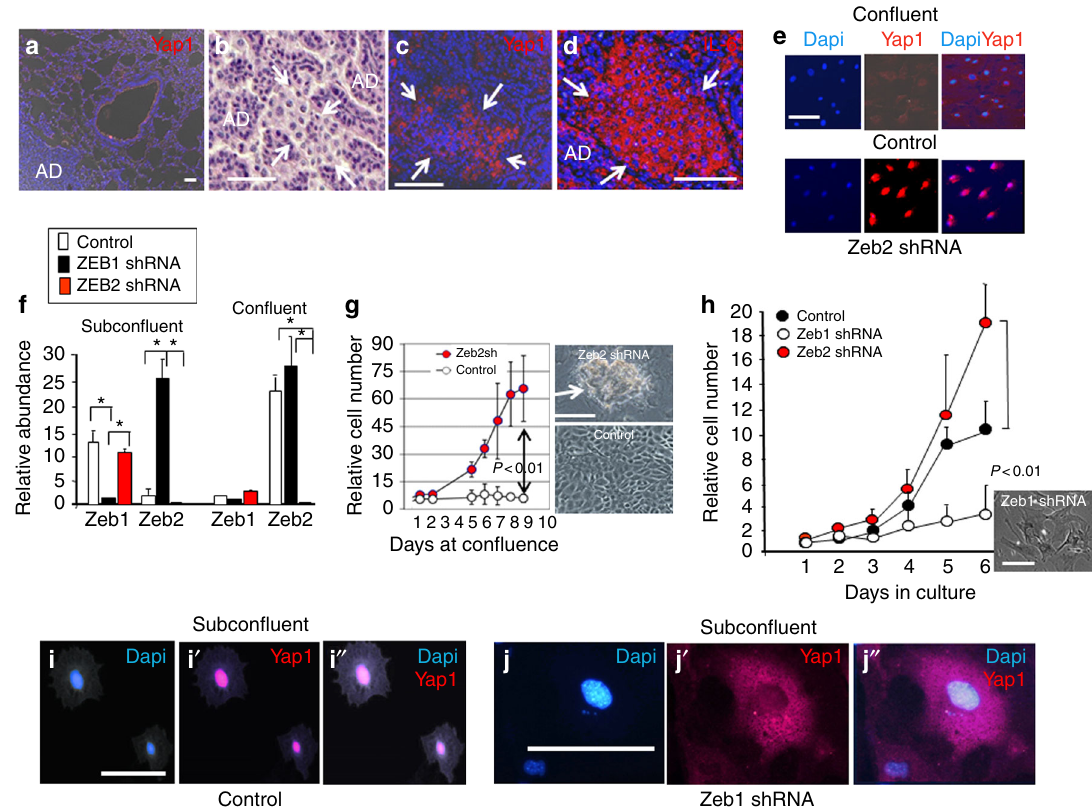
Fig. 4 Zeb2 blocks nuclear translocation of Yap1. a Immunostaining showing Yap1 is not concentrated in the nucleus in normal lung, AAH, and AD. b A cluster forming in the interior of an AD at P170. Arrows show the cluster border. c Yap1 is translocated to the nucleus in clusters. d The downstream target of Yap1, IL-6, is induced with nuclear translocation of Yap1 in clusters. e Cells in culture were allowed to reach con fl uence, and were then treated with 75 pM Tgf- β 1 for 12 h. Note the block in Yap1 nuclear translocation at con fl uence. Similar cytoplasmic retention of Yap1 was evident at con fl uence in the absence of Tgf- β 1. Zeb2 shRNA knockdown maintains nuclear Yap1 at con fl uence. f Real-time PCR showing Zeb1 mRNA is repressed and Zeb2 mRNA is induced when cells are allowed to become con fl uent. g Control cells remain growth-arrested at con fl uence, but knockdown of Zeb2 allows continued proliferation and cell outgrowth into foci. h Knockdown of Zeb1 leads to loss of proliferation and senescent morphology 29 . i – i ″ Yap1 is nuclear in subcon fl uent control cells. j – j ″ Yap1 becomes sequestered in the cytoplasm of subcon fl uent cells when Zeb1 is knocked down. Bars are 50 μ m in panels a – e , and 25 μ m in panels f –